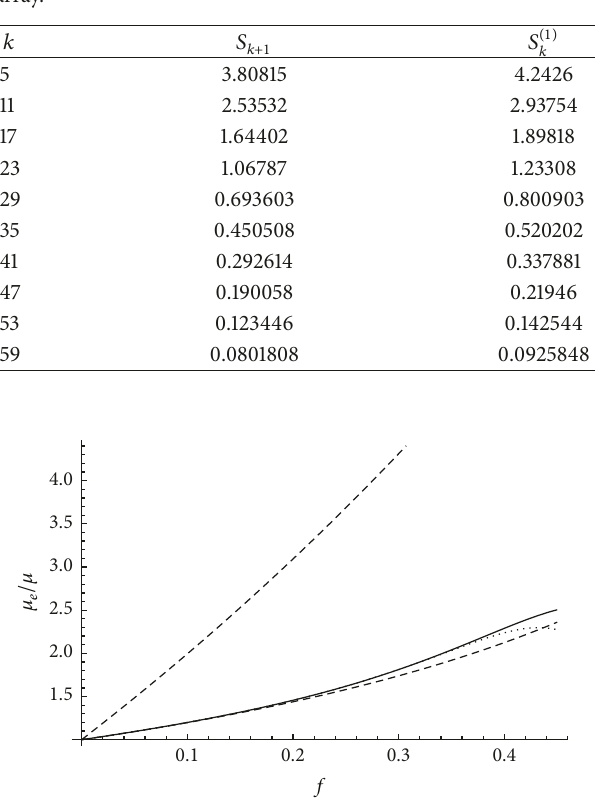
Table 1: The nonzero values of the lattice sums for the hexagonal array.